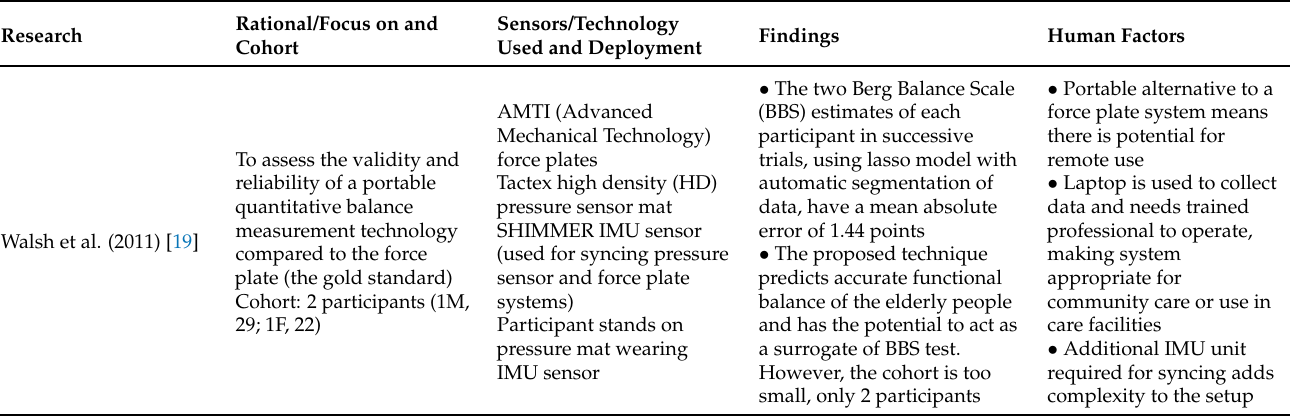
Table 1. Balance assessment using technology literature review summary.